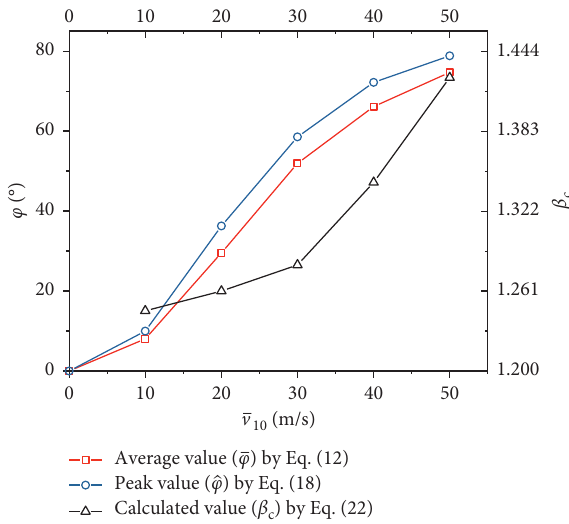
) on the windage yaw angle ( φ ). 10